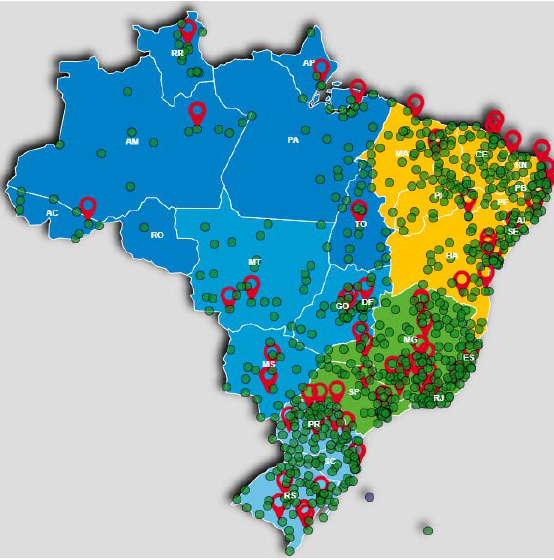
Figure 2. Distribution of UAB’s institutions and face-to-face learning centers. Reprinted from “SiSUAB2,” by CAPES, the Brazilian Coordination for the Improvement of Higher Education Personnel Agency, 2019 ( https://sisuab2.capes.gov.br/sisuab2/login.xhtml). Copyright 2019 by Coordenação de Aperfeiçoamento de Pessoal de Nível